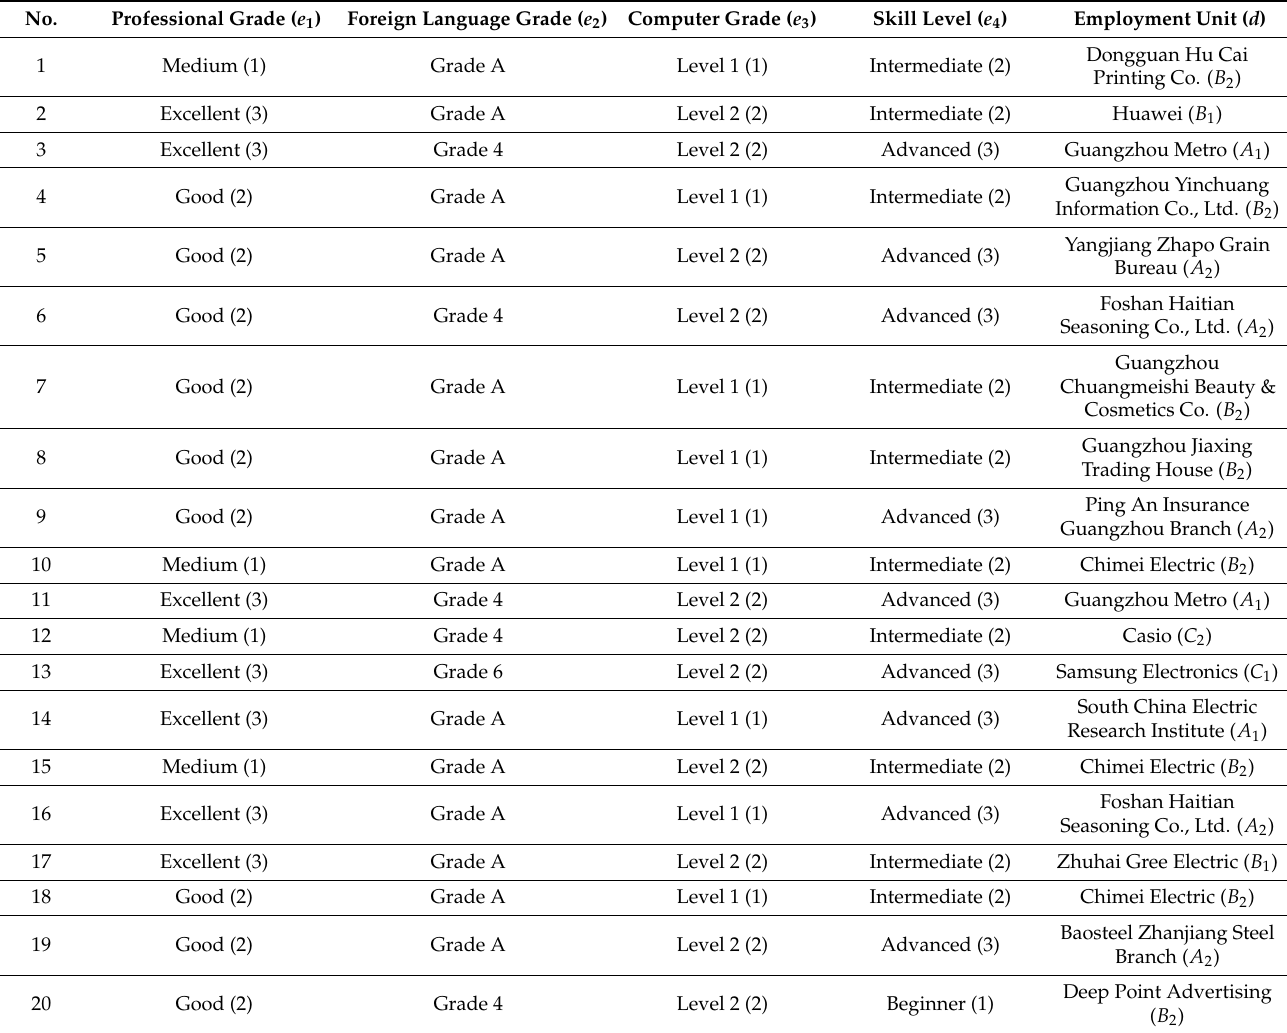
Table 1. Student employment